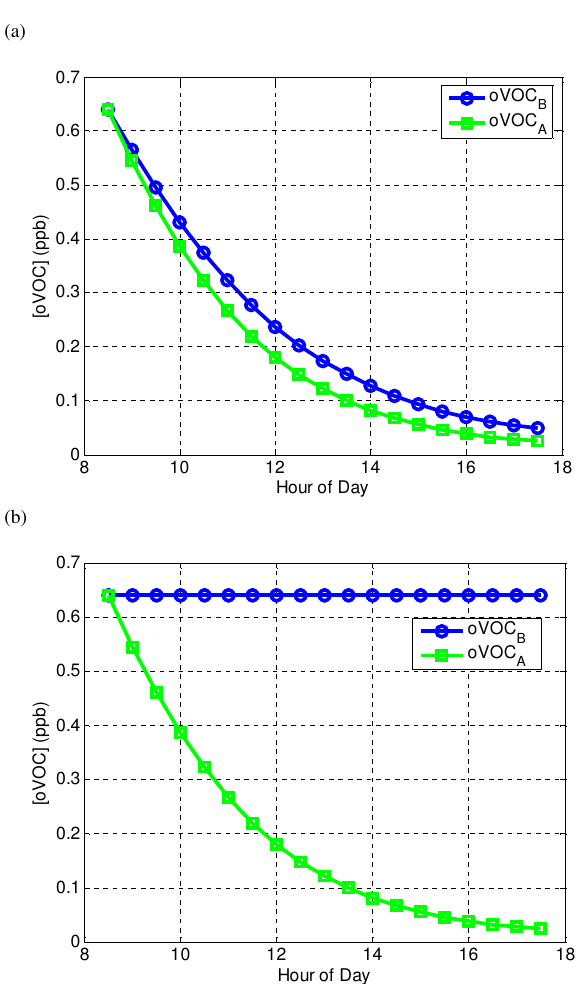
Fig. 1. oVOC profiles for time-dependent simulations of APNs: (a) Case A: both oVOCs decreasing exponentially with e-folding life- times of ∼ 2.5 (oVOC A ) and ∼ 3.5h (oVOC B ) with no production (P/L=0) and (b) Case B: oVOC A decreasing as in scenario A, and oVOC B having equal production and loss rates (P/L=1).